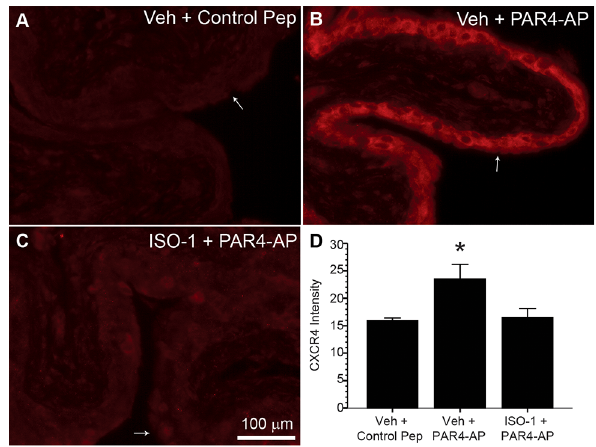
Fig 6. PAR4 activation increases urothelial levels of MIF receptor, CXCR4. Panels ( A , B , C ) show the CXCR4 immunofluorescence in representative bladders which is restricted to urothelium. White arrows identify the urothelium intraluminal surface. More intense urothelial CXCR4 immunofluorescent labeling is apparent in PAR-4P-exposed bladders ( B ) than in control peptide-treated bladders ( A ). Pre-treatment with MIF antagonist, ISO-1 ( C ) prevented this increase. D ) Densitometry showed that average urothelial CXCR4 immunofluorescence (N = 6 per group) significantly increased after intravesical PAR4-AP when compared to control peptide-treated animals ( * p (cid:1) 0.05). This effect was prevented by ISO-1